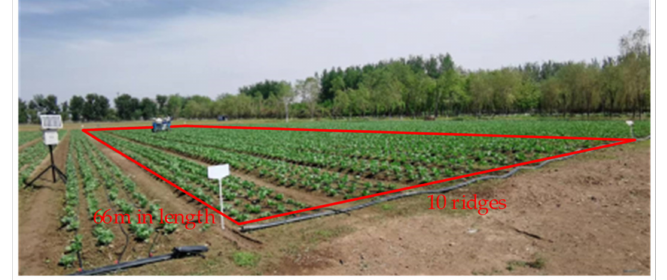
Figure 8. Cabbage experiment